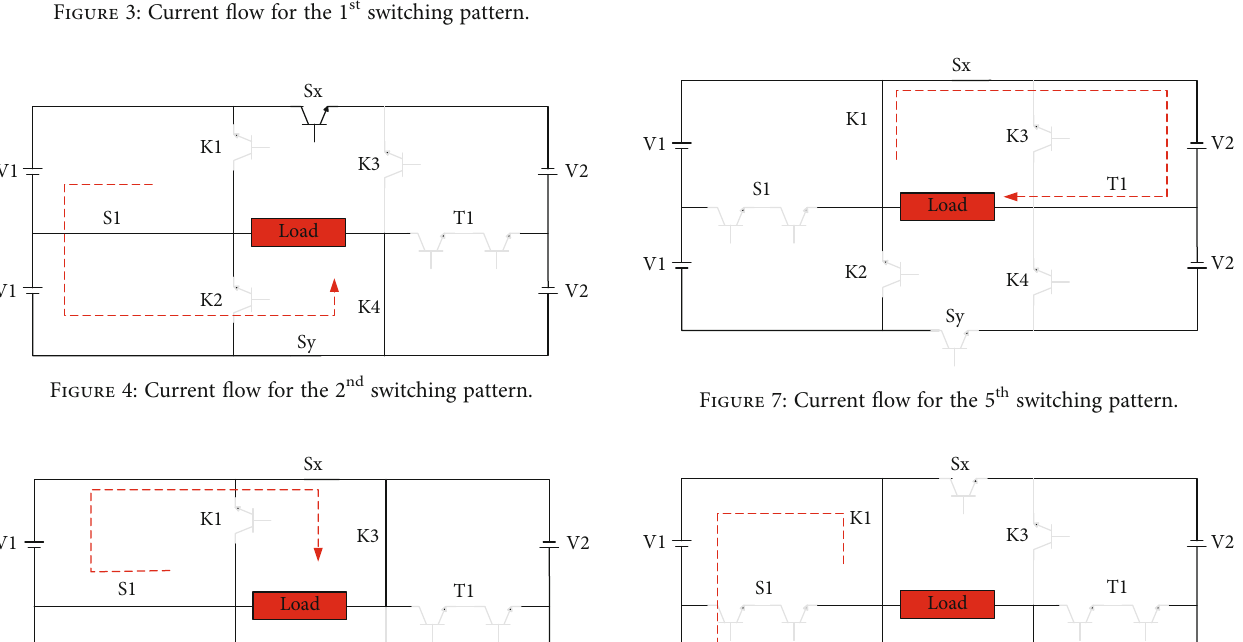
Figure 3: Current fl ow for the 1 st switching pattern.